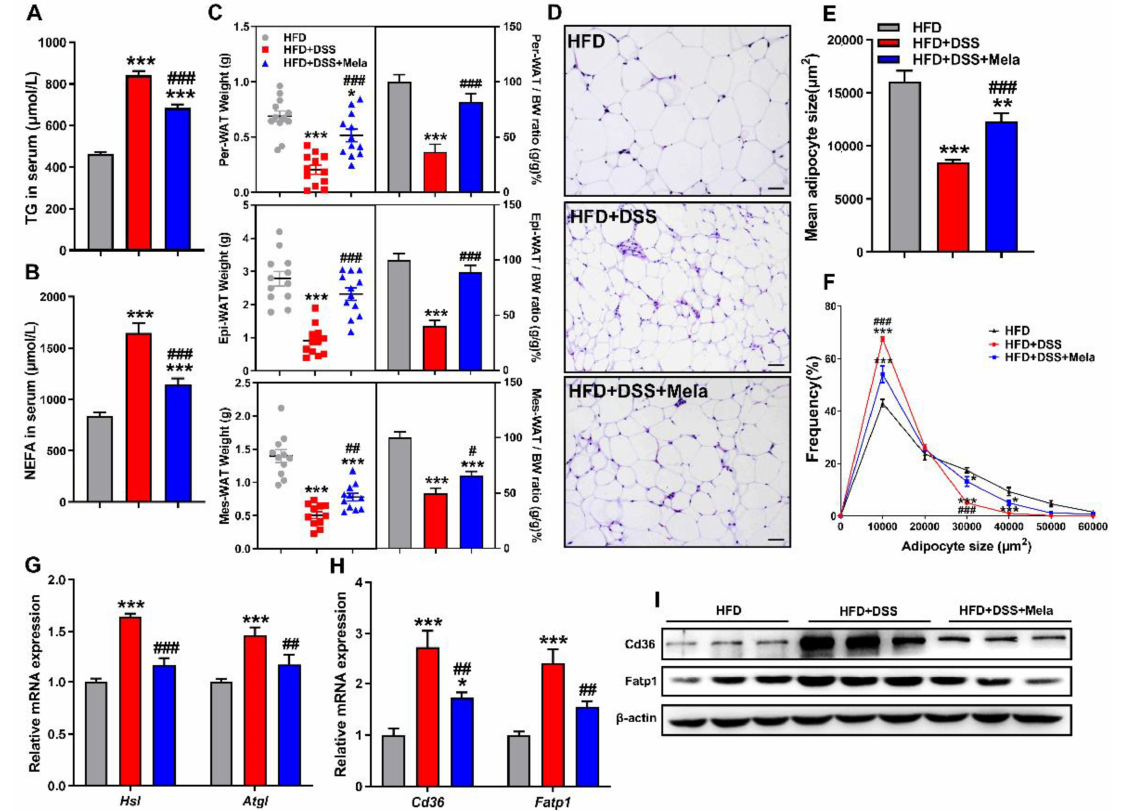
Figure 6. Melatonin inhibits lipolysis and fatty acid transport in the white adipose tissues of DSS-treated obese mice. ( A , B ) Serum concentrations of TC ( A ) and NEFA ( B ). ( C ) Per-WAT, Epi-WAT, and Mes-WAT weights and their respective ratios. ( D ) Representative H&E staining of Mes-WAT sections (scale bar = 100 µ m). ( E , F ) Mean mesenteric adipocyte size ( E ) and adipocyte size frequency ( F ). ( G , H ) Mes-WAT mRNA expression of genes involved in lipolysis ( Hsl and Atgl ) ( G ) and lipid transport ( Cd36 and Fatp1 ) ( H ) was measured by real-time PCR analysis. ( I ) The Cd36 and Fatp1 protein levels were examined in Mes-WAT. Values are shown as the means ± SEM. n = 10. * p < 0.05, ** p < 0.01, *** p < 0.001 compared with HFD; # p < 0.05, ## p < 0.01, ### p < 0.001 versus HFD +